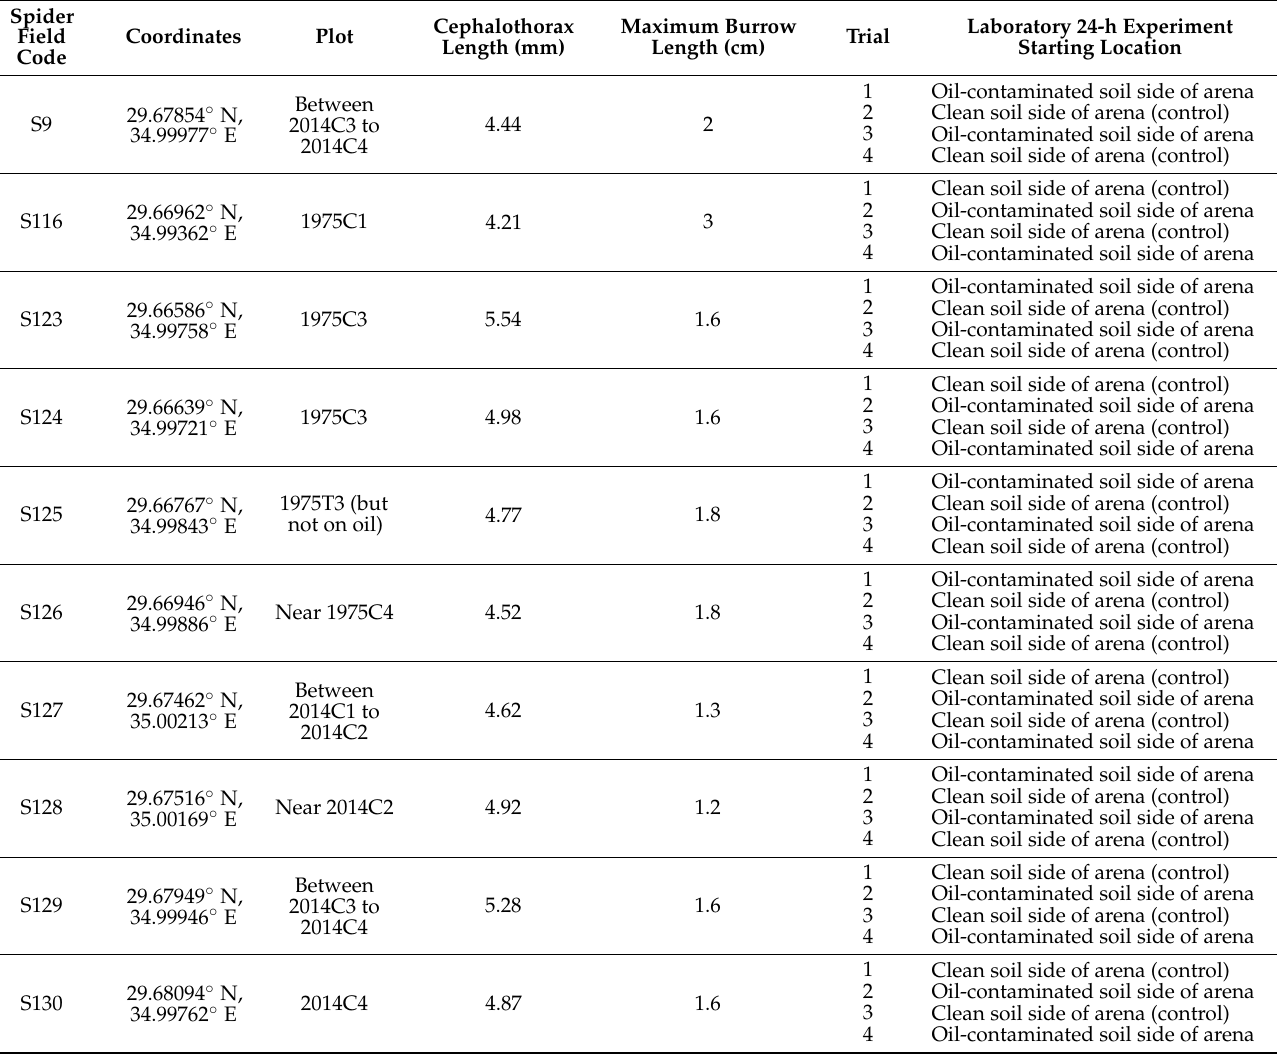
Table A2. Sahastata spiders collected from ‘Avrona nature reserve for laboratory experiments, their collecting coordinates, plot, cephalothorax length (mm), maximum burrow length (cm), and starting location side of arena in the 24-h